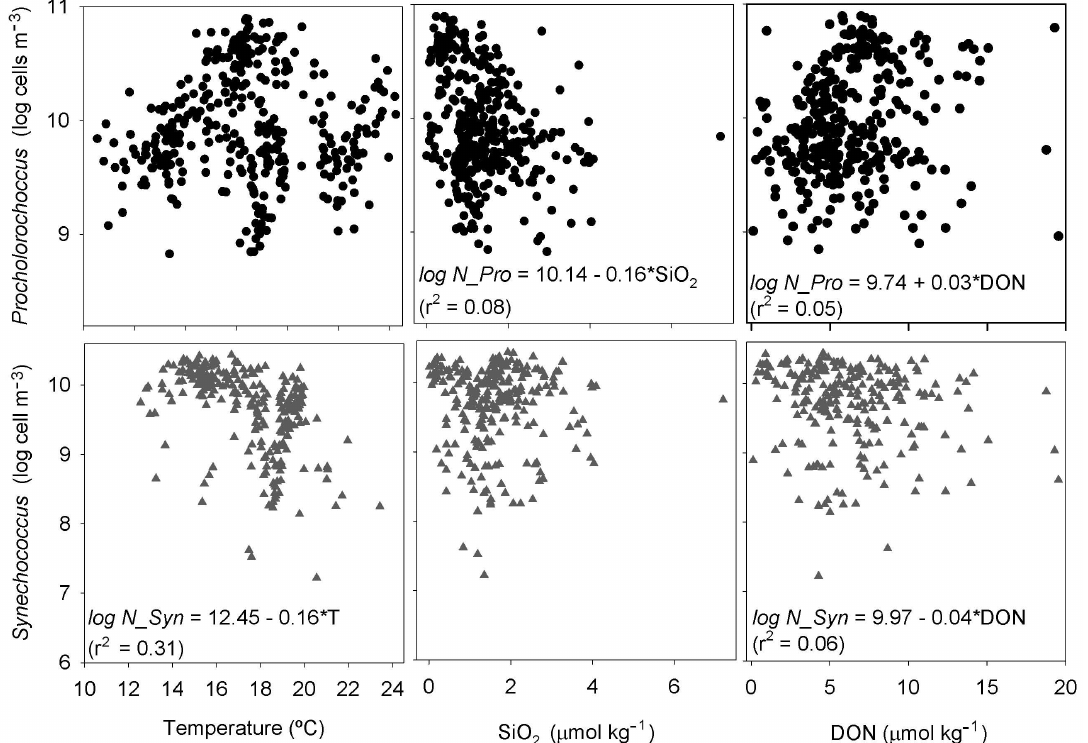
Fig. 5. – Relationship between Prochlorochoccus (black circles) and Synechococcus (gray triangles) abundance (log cell m –3 ) and temperature (°C), silicate (µmol kg –1 ) and dissolved organic nitrogen (µmol kg –1 ) concentrations. The equations for the statistically significant linear regressions are